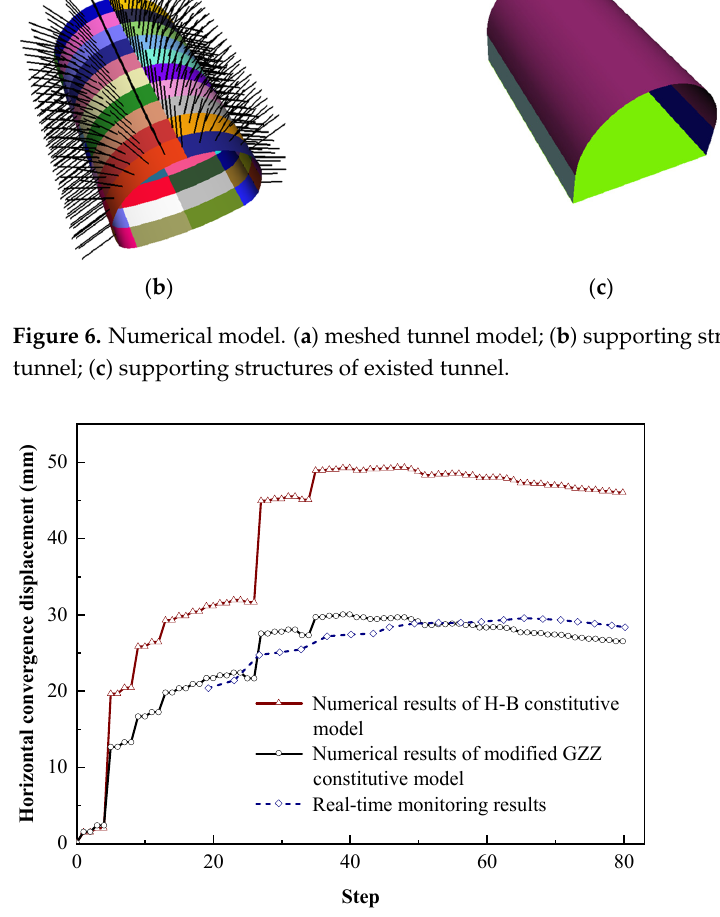
Figure 7. Horizontal convergence displacement of side wall of new constructing tunnel at ZK 72 + 530 m.